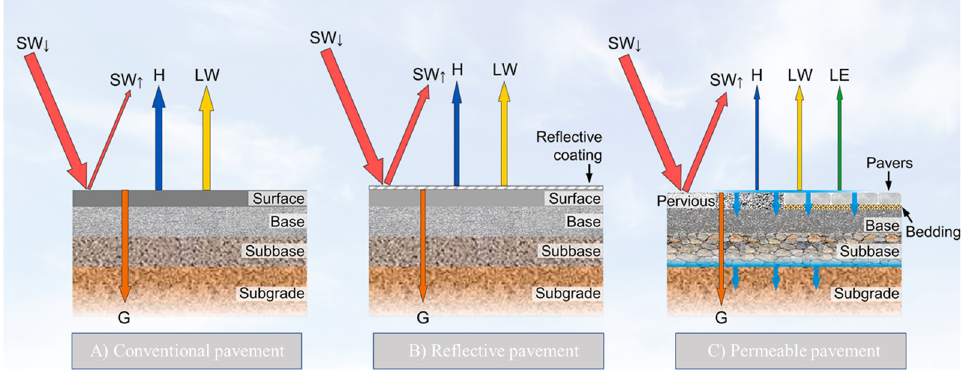
Figure 3. Structures of typical ( A ) conventional pavement, ( B ) reflective pavement, and ( C ) permeable pavement (pervious concrete or pavers, with infiltration shown in light blue). Arrows with letters in each subplot show the simplified energy balance for each ↓ pavement type: SW – ↑ ↓ ↑ SW + LW = G + H + LE, where SW , SW , LW, G, H, and LE denote downward short-wave radiation (solar radiation), upward short-wave radiation (reflected), net long-wave radiation, heat conduction, sensible heat flux, and latent heat flux, respectively. Roofs represent a very high fraction of the exposed urban area. The available free ground area in the urban environment is quite limited and of very high economic value, and it is relatively complex to implement large-scale mitigation technologies. Several experimental and theoretical studies have been performed to identify the energy conser- vation potential of green roofs [31,32]. There are two main types of green roofs: expen- sive roofs that are light and covered by a thin layer of vegetation, and intensive roofs that are heavier and can support small trees and shrubs. The specific energy benefits de- pend on the local climate; the green roof design; and, more importantly, specific build- ing characteristics. The system performs better in dry climates because heat transfer benefits are mainly provided through latent heat processes in green roofs. In parallel, the thickness and the thermal characteristics of the vegetative roof broadly define its U val- ue and the corresponding heat transfer to the building. In contrast, the type and features of the plants (LAI) specify the shading levels and the transfer of radiation through the layers. Finally, watering is essential, as it deter- mines the latent heat release and regulates the thermal balance of the roof. The green roof type implemented in our study consists of a shallow Sedum area with herbaceous perennials and grasses, as presented in Figure 4. Figure 5 shows the green roof’s main heat fluxes and energy balance. Figure 4. Green roof and its consisting layers.